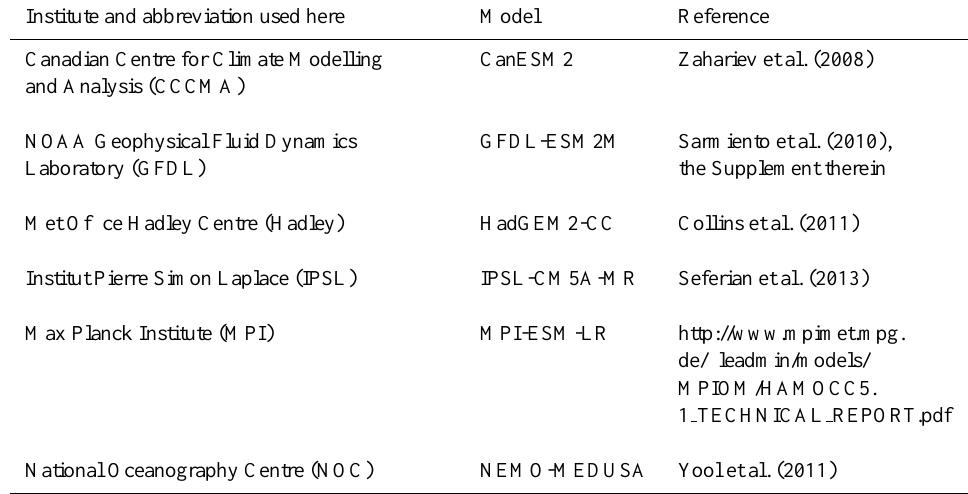
Table 1. List of models used in this study and relevant references for the biogeochemical component of the